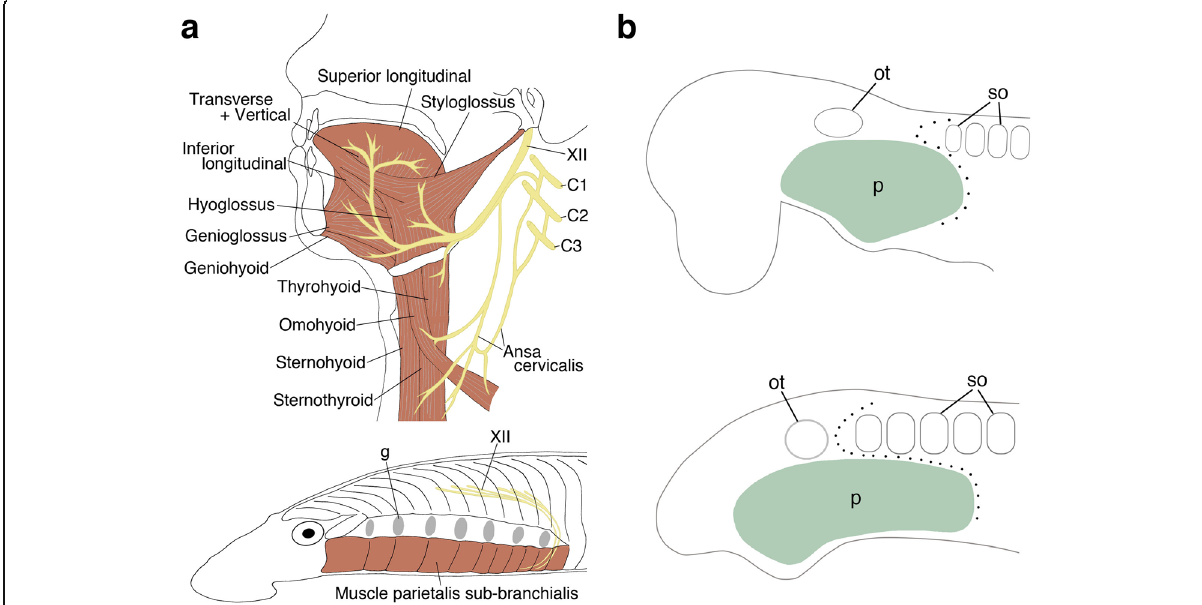
Fig. 1 Vertebrate HBMs and the head – trunk interface. Human HBMs are composed of multiple voluntary muscles innervated by the hypoglossal nerve (XII) and cervical spinal nerves (C1 – 3) ( a , top). The lamprey also possesses HBMs and the hypoglossal nerve ( a , bottom). Schematic diagram of the head – trunk interface in gnathostomes ( b , top) and the lamprey ( b , bottom). Dotted lines indicate the interface. C1 – 3, cervical spinal nerves; g, gill opening; ot, otic vesicle; p, pharyngeal arches; so,